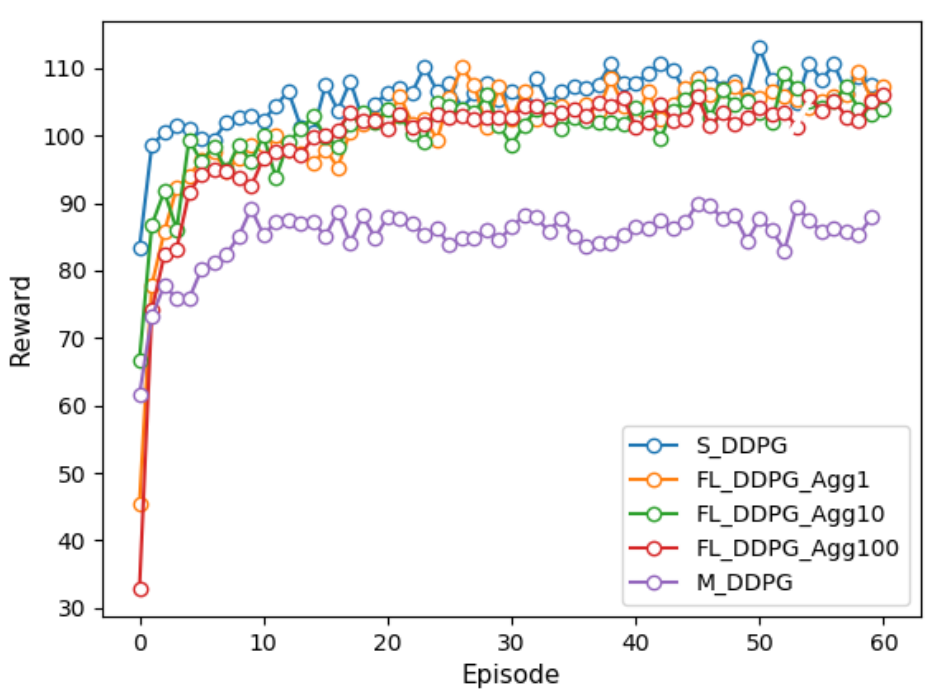
Figure 3. Comparison of reward of DDPG methods under episodes.